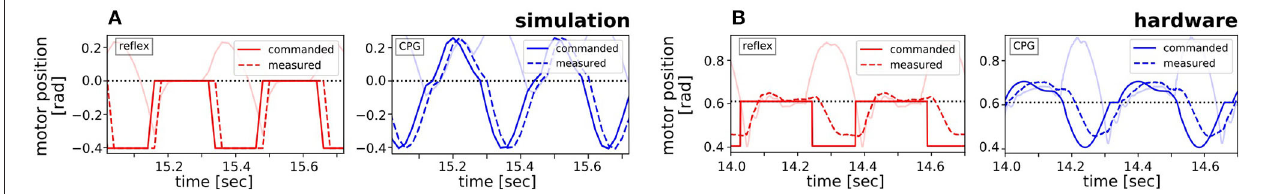
FIGURE 7 | Comparison of the commanded (solid line) and measured (dotted line) motor signal for the reflex (red) and the adaptive CPG (blue), exemplarily shown for the knee without applied load. (A) In the simulation, the ideal curve could be followed. (B) In the hardware experiment the commanded signal was delayed through the motor dynamics leading to overall more similar control